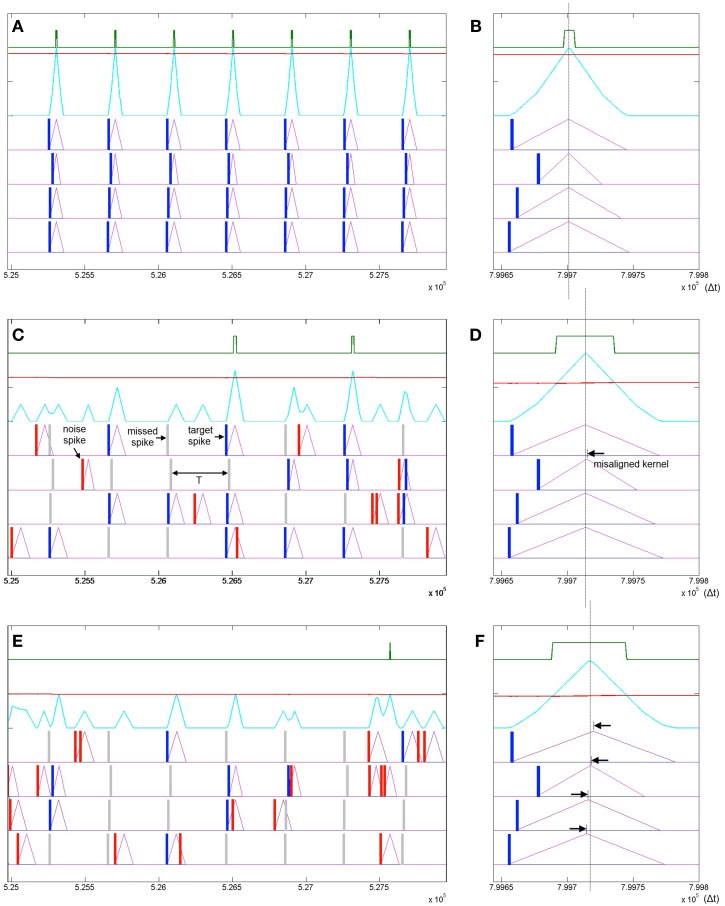
Learning spatio-temporal spike patterns in the presence of both Poisson spike noise and missing target spikes. Panel (A) shows the presentation of seven patterns in the middle of a simulation sequence with a noiseless environment. The kernels are highly adapted (Δr2 = Δrmax), the threshold is high and the output spikes are narrow indicating high certainty. Panel (B) shows the result of a final noiseless test pattern at the end of the simulation showing in detail that the kernels resulting from the test pattern peak at the same time. Panel (C) shows the same interval of the same simulation as panel (A) but with a 1:1 signal to noise ratio where the probability of a target spike being deleted is half or P(signal) = 0.5 and the Poisson rate is also half such that P(noise) = 0.5/T. Panel (D) shows the result of a noiseless test pattern presentation at the end of the simulation. The increased level of noise has resulted in an incorrect ramp step (Δr2) such that the r2 kernel peaks slightly late (black arrow). Panel (E) shows a simulation with a 1:2 signal to noise ratio. Panel (F) shows that the high noise level has resulted in slight misalignment of all four kernels.